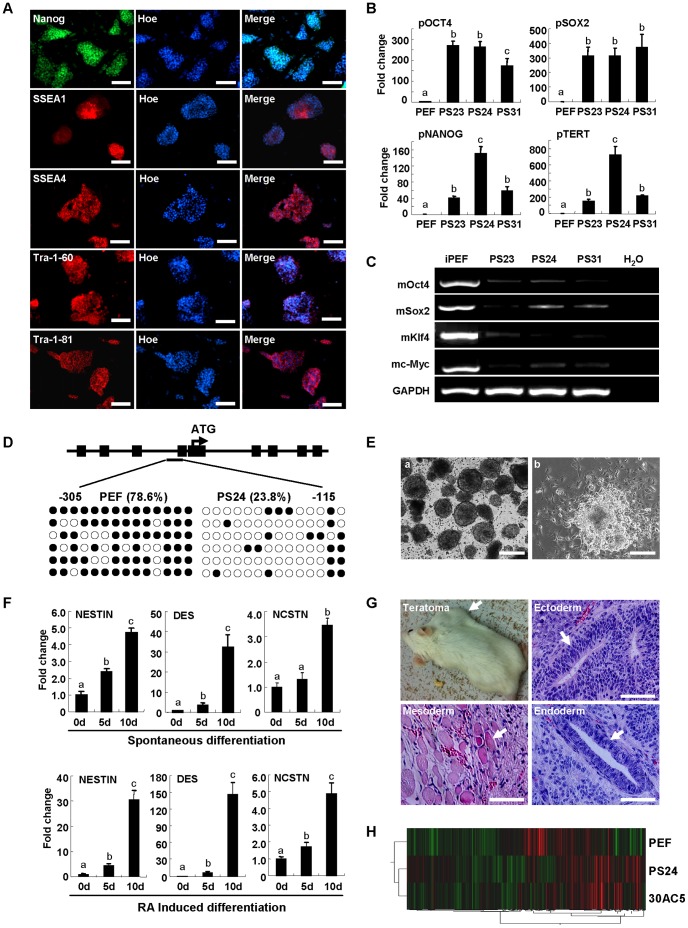
Characterization of piPS cells.A, The immunostaining of piPS cell line PS24 at passage 10. The nuclei were stained with Hoechst 33342 (Hoe). Scale bars, 100 µm. B, Quantitative RT-PCR analysis of expressions of porcine pluripotent factors (pOCT4, pSOX2, pNANOG and pTERT) in three piPS lines (PS23, PS24, PS31) and PEF. y axis represents the fold change relative to β-actin. C, Semi-quantitative RT-PCR analysis of the transgene expression (mOct4, mSox2, mKlf4, mc-Myc) in three piPS lines. iPEF, PEF cells were infected by 4F for 6 days. GAPDH was used as an internal control. D, The DNA methylation analysis of OCT4 promoter region in PS24 cell line and PEF by bisulfite sequencing. Open circles indicate unmethylated CpG, and filled circles indicate methylated CpG. E, Embryoid bodies derived from PS24 line were cultured in suspension for 5 days (a), and then cultured in tissue culture plat for the differentiation (b). Scale bars, 200 µm. F, The quantitative RT-PCR analysis of PS24 clone that was differentiate into three germ layers, NESTIN for ectoderm, DES for mesoderm and NCSTN for endoderm. The upper panels show the spontaneous differentiation for 0, 5 and 10 days, and the lower panels show the induced differentiation by RA for 0, 5 and 10 days. The y axis represents the fold change vs. GAPDH. G, Hematoxylin-eosin stained tissue section of teratoma derived from piPS clone PS24. Cells were transplanted subcutaneously in CB-17 SCID mice for 8 weeks. The teratoma and tissues representing three germ layers, neural epithelium (ectoderm), muscle (mesoderm) and gut epithelium (endoderm), are indicated by arrows. Scale bars, 100 µm. H, The heat map shows the single-linkage hierarchical clustering of microarray data (n = 20640 probes) for 2 piPS cell lines (PS24 and 30AC5) and PFF. The relative abundance of gene expression was clustered by Euclidean correlation and complete linkage. Data indicate mean ± SD (n = 3). Different letters (a, b, c) indicate significantly different between two groups, p<0.01 by Student’s t test.